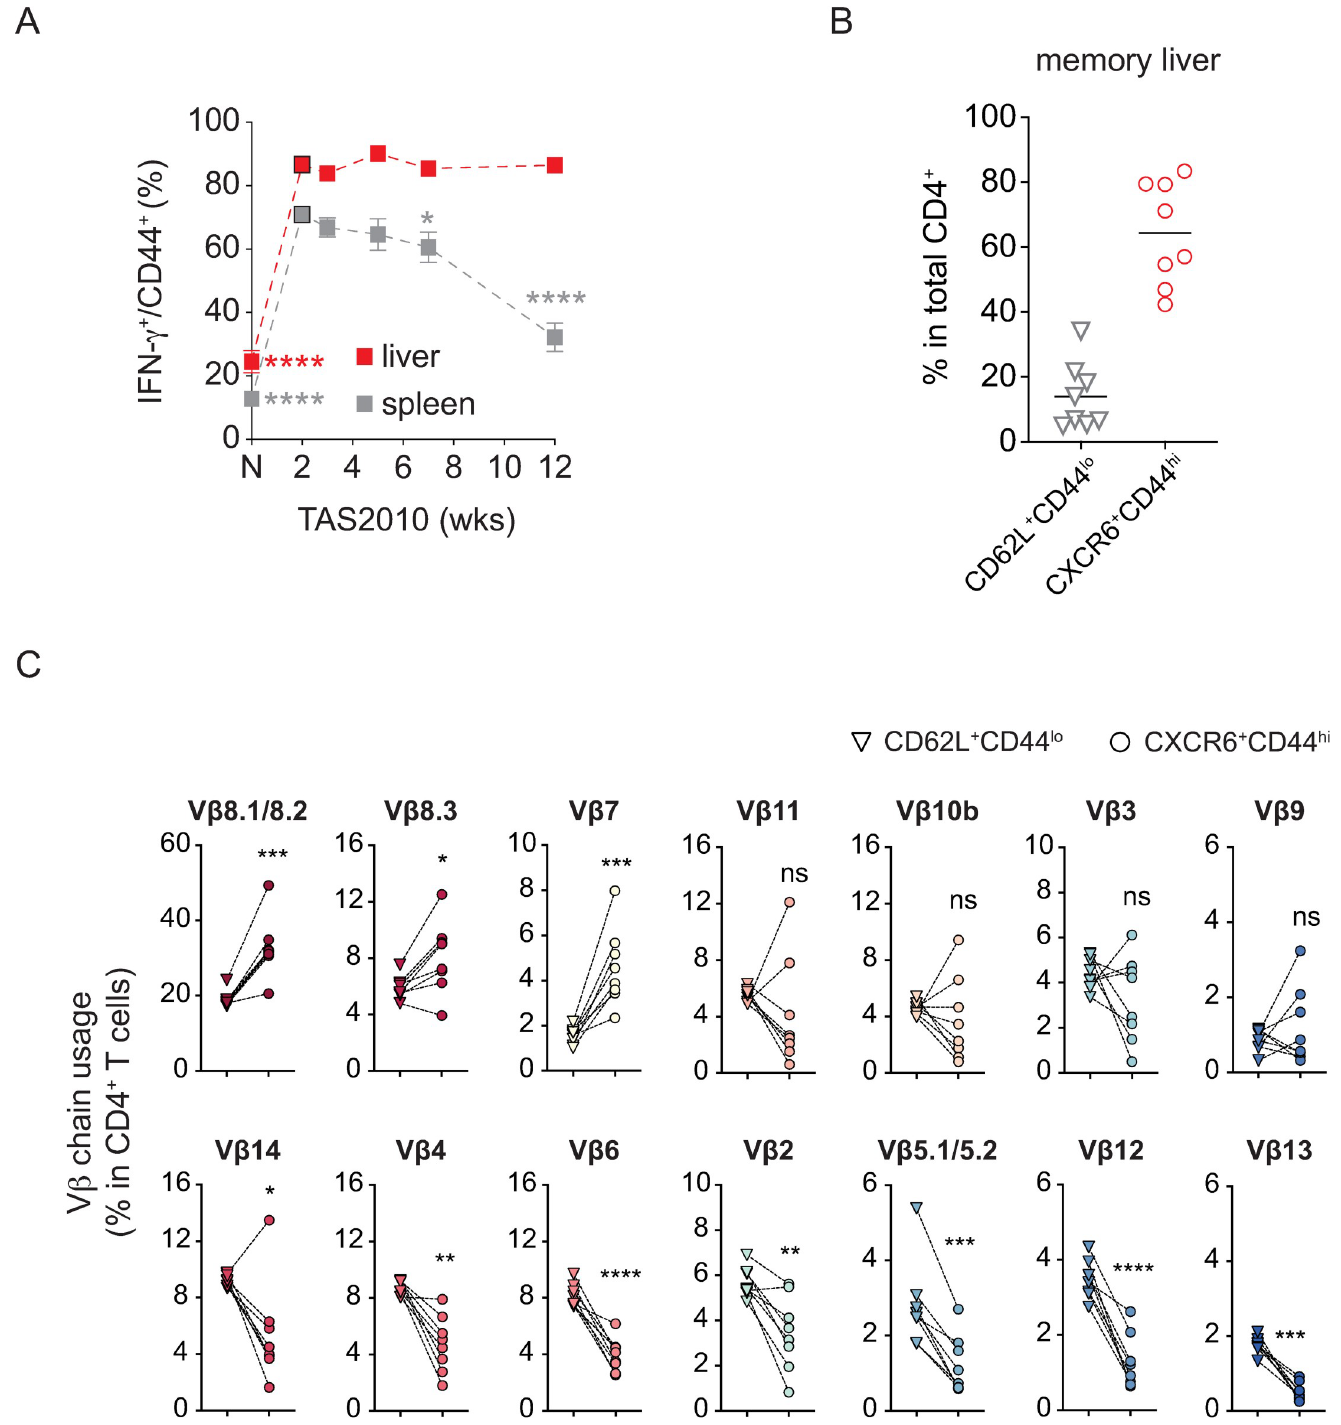
Fig 4. Liver migratory CD4 + T cells show preferential usage of selected V β chains compared to na ï ve cells. IFN- γ -eYFP in/in or B6 mice were i.v. infected with 200CFU TAS2010. At week different time points p.i. mice were euthanased; the liver was then perfused with PBS to remove circulating cells. (A) Percentage of IFN- γ - eYFP + cells among CD44 + CD4 + T cells in the spleen and liver (n = 4–12). (B) The majority of liver CD4 + memory (week 12) T cells displayed a CXCR6 + CD44 hi phenotype, whereas CD62L + CD44 lo na ï ve cells were present in lower numbers. (C) The frequency of 15 individual V β chains within total or indicated subset of liver CD4 + memory T cells were assessed for individual. Together these chains accounted for 78% (range: 74.4–85.5%) of total CD4 + T cells. For each individual V β chain, its frequency in the CXCR6 + CD44 hi CD4 + T cells was compared to that in the na ï ve subset in the same animal; for better visualisation, a dotted line is drawn between